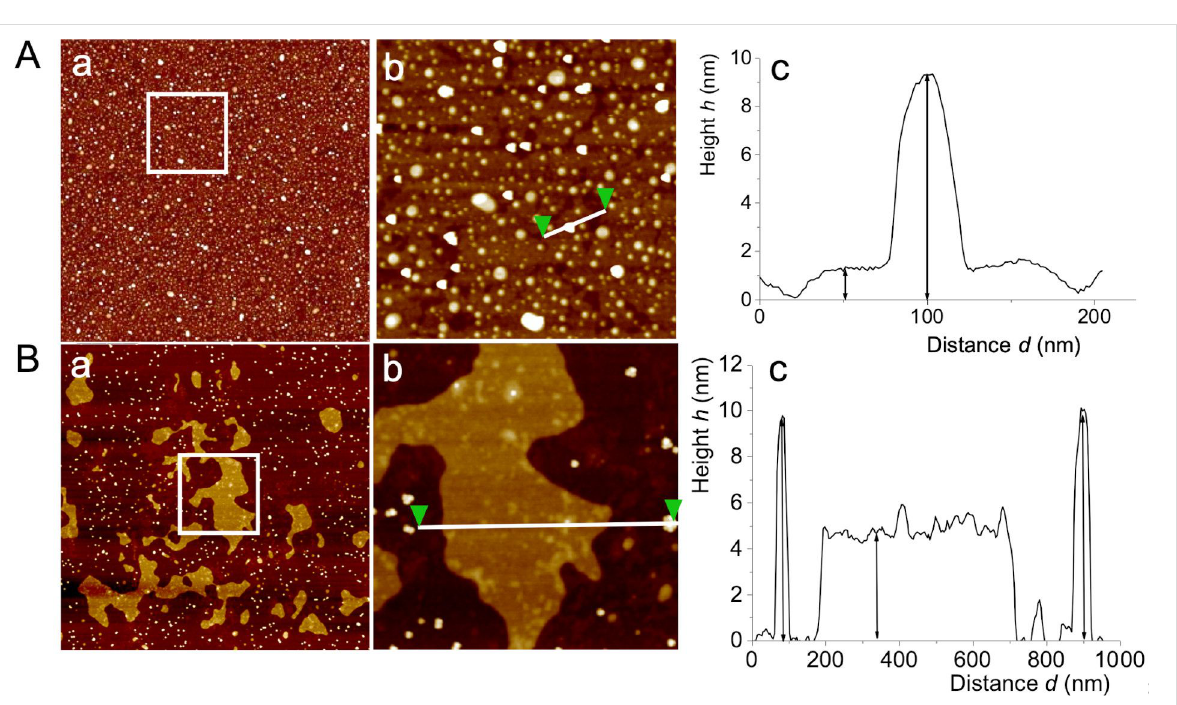
Figure 11: a) AFM topography image (4 × 4 µm) of the mixed spin-coated films composed of DPPC and IONP@C 2 F 5 OEG 8 Den (Panel A) and IONP@C 2 H 5 OEG 8 Den (Panel B); b) magnification images (1 × 1 µm) of the white square shown in a); c) height profiles taken between the two green triangles in the corresponding image in b). Co-dispersions of DPPC (0.5 mM) and IONPs (0.002 mg mL − 1 ) in ethanol were spin-coated on silicon